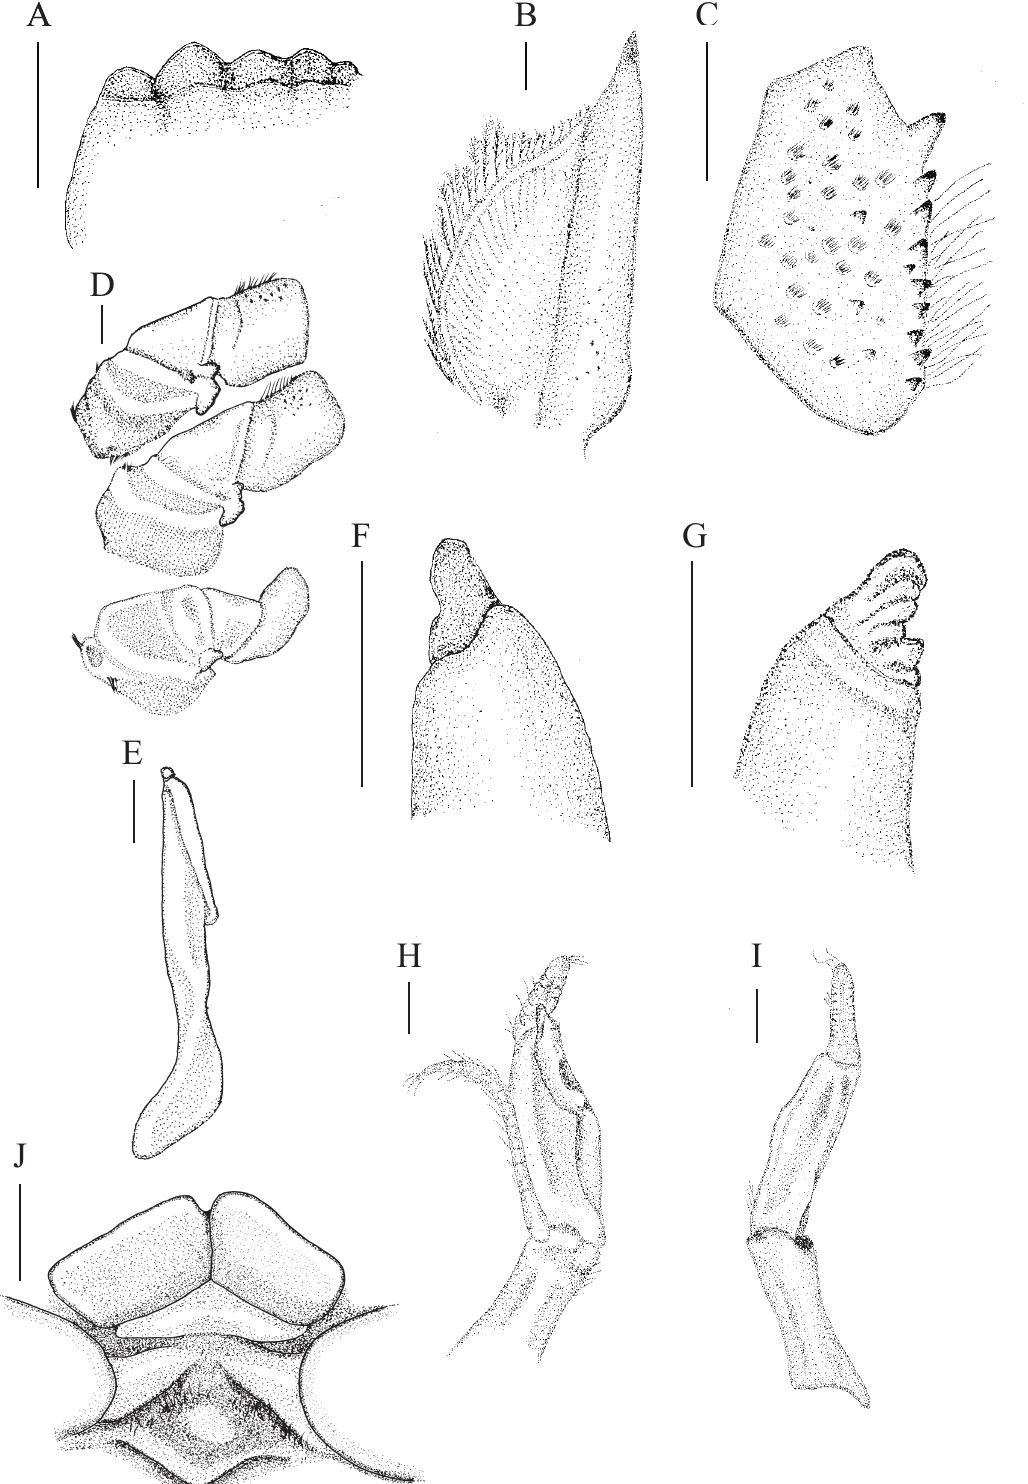
Figure 6. Pacifastacus leniusculus trowbridgii (Stimpson, 1857): all figures from syntypic male #1 (USNM 2080) except J, from syntypic female #1 (USNM 2080). A, Distocaudal view of denticle of mandible; B, dorsal view of antennal scale; C, dorsal view of merus of third maxilliped; D, proximal podomeres of pereiopods; E, mesial view of first pleopod; F, mesial view of distal portion of first pleopod; G. lateral view of distal portion of first pleopod; H, mesial view of second pleopod; I, lateral view of second pleopod; J, caudal thoracic sternal area of female. Scale bars = 2 mm, except A = 0.5